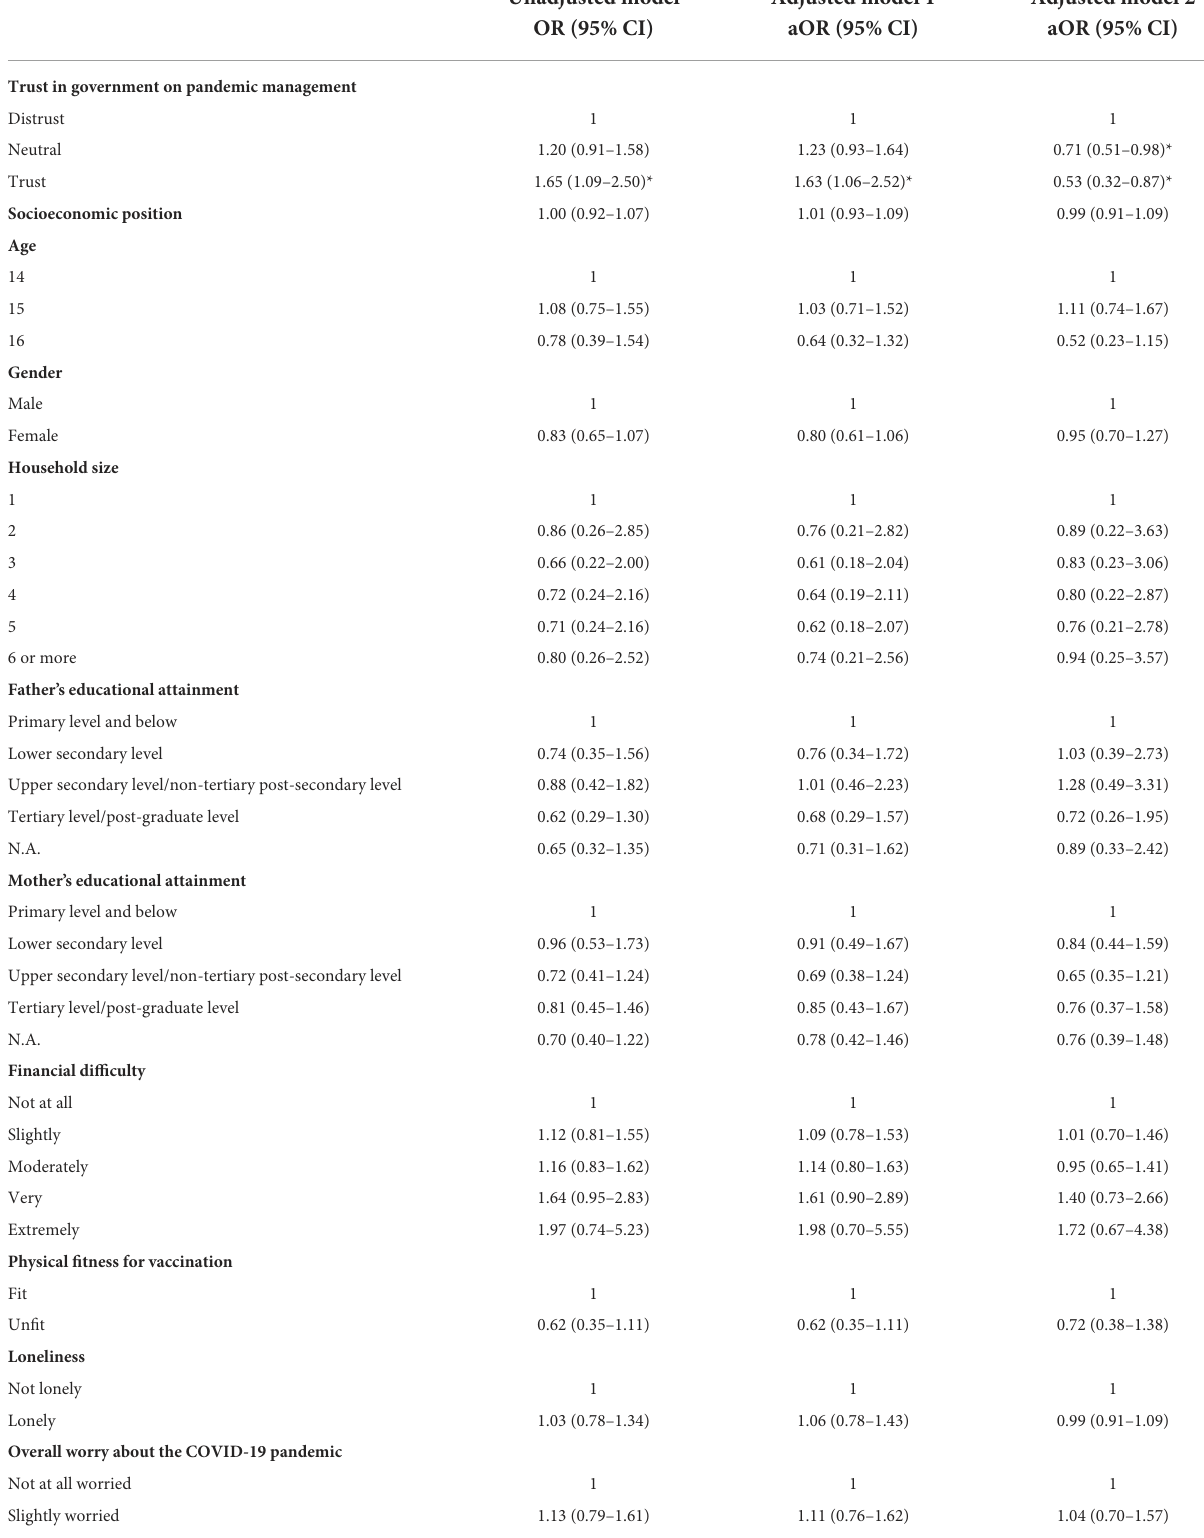
TABLE 3 Multivariable logistic regression on predictors of COVID-19 vaccination ( n =